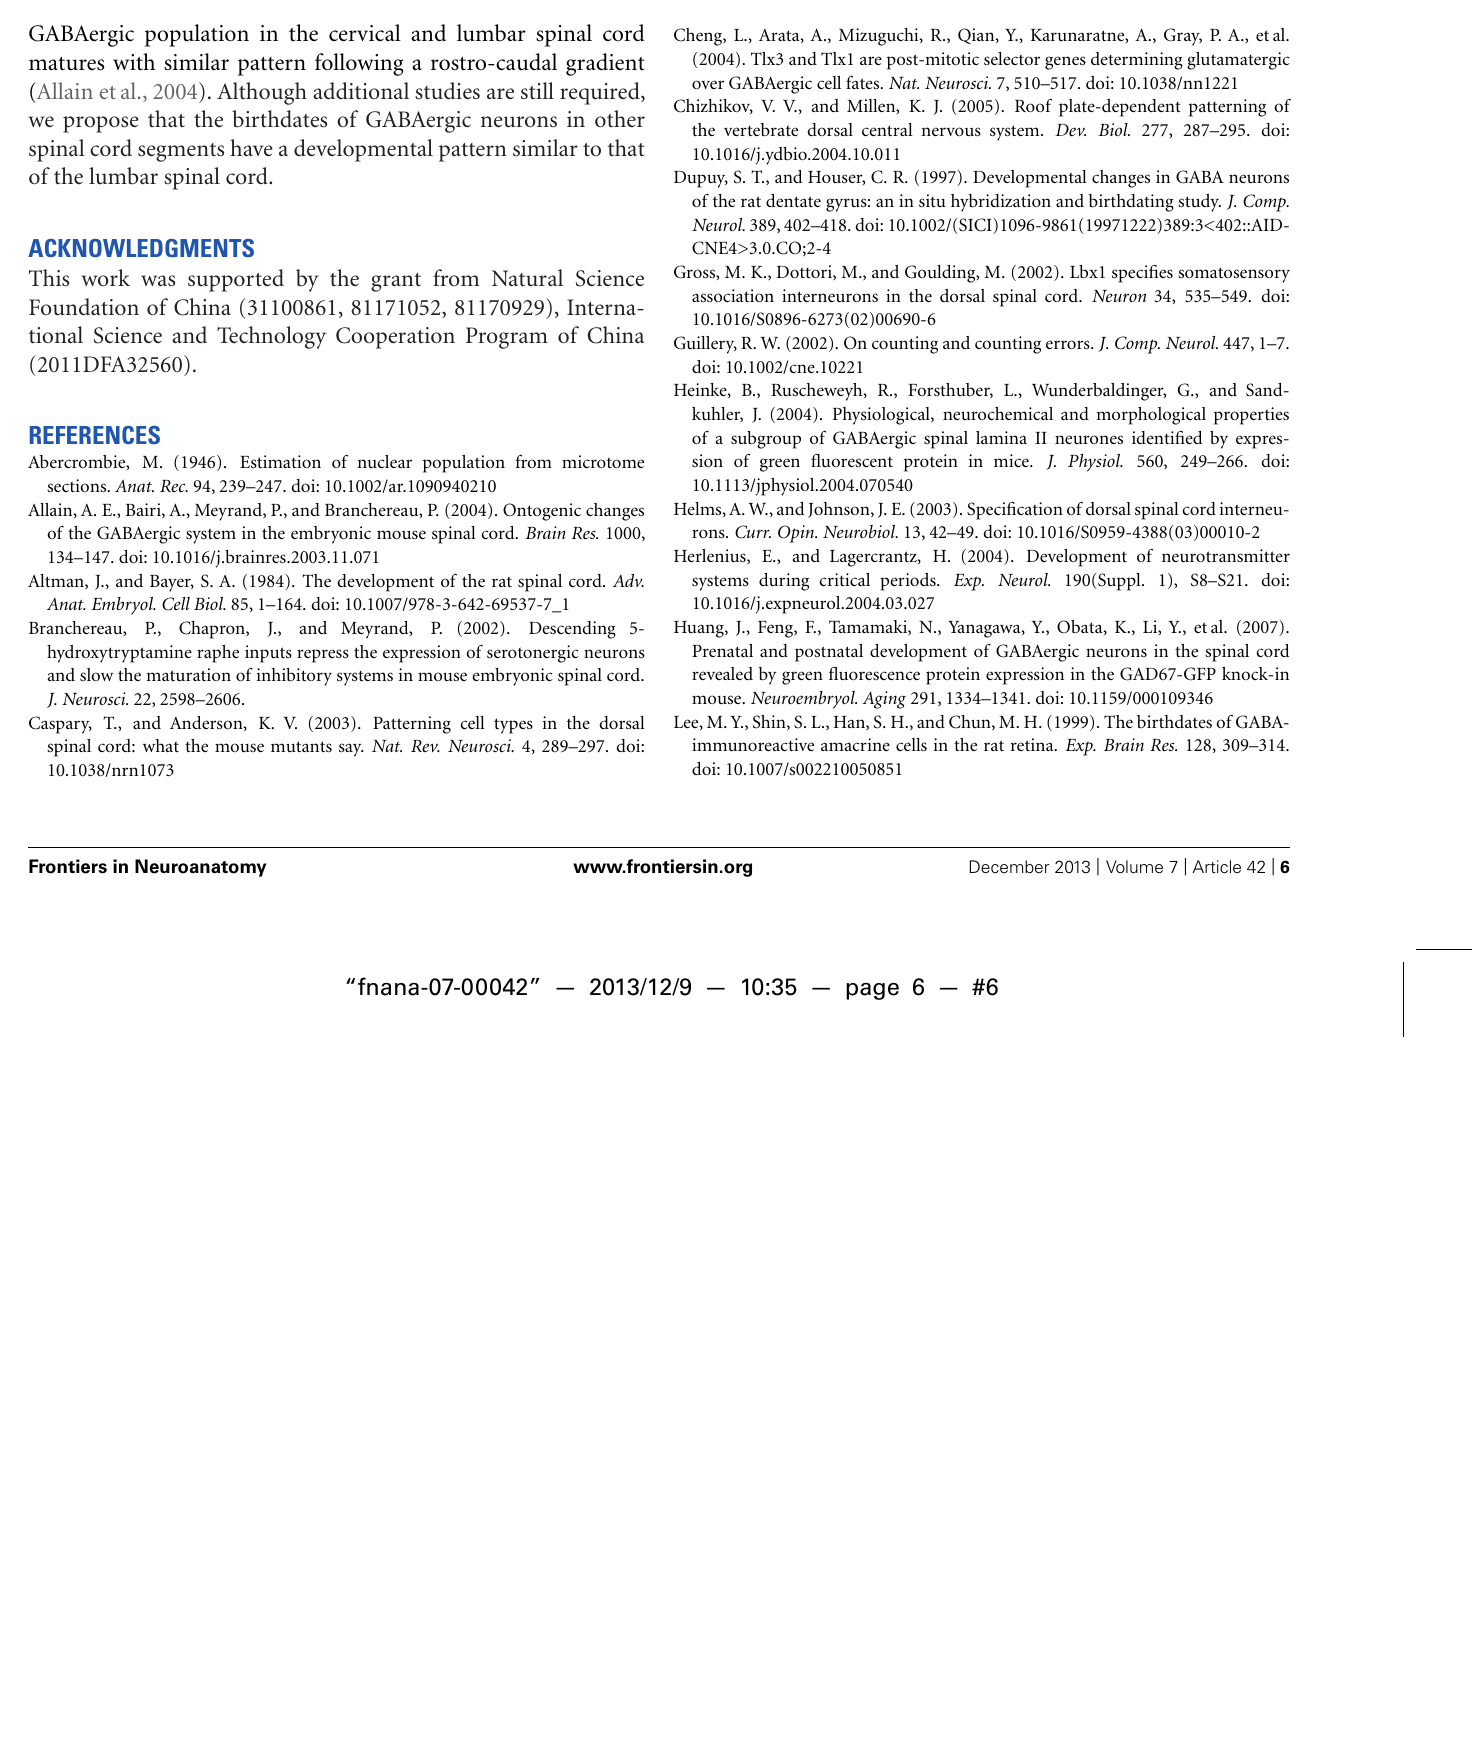
indicates the median. Statistical differences were assessed by non-parametric method, namely Kruskal–Wallis test. * P < 0.05 compared with that of E10.5 and E11.5. # P < 0.05 compared with that of E10.5 and E12.5. $ P < 0.05 compared with that of E10.5 and E13.5. Borders of lamina I, lamina II, and lamina III are depicted as dashed lines. Scale bars = 50 μ m in (D) (applies to A–D ) and 20 μ m in (H) (applies to E–H